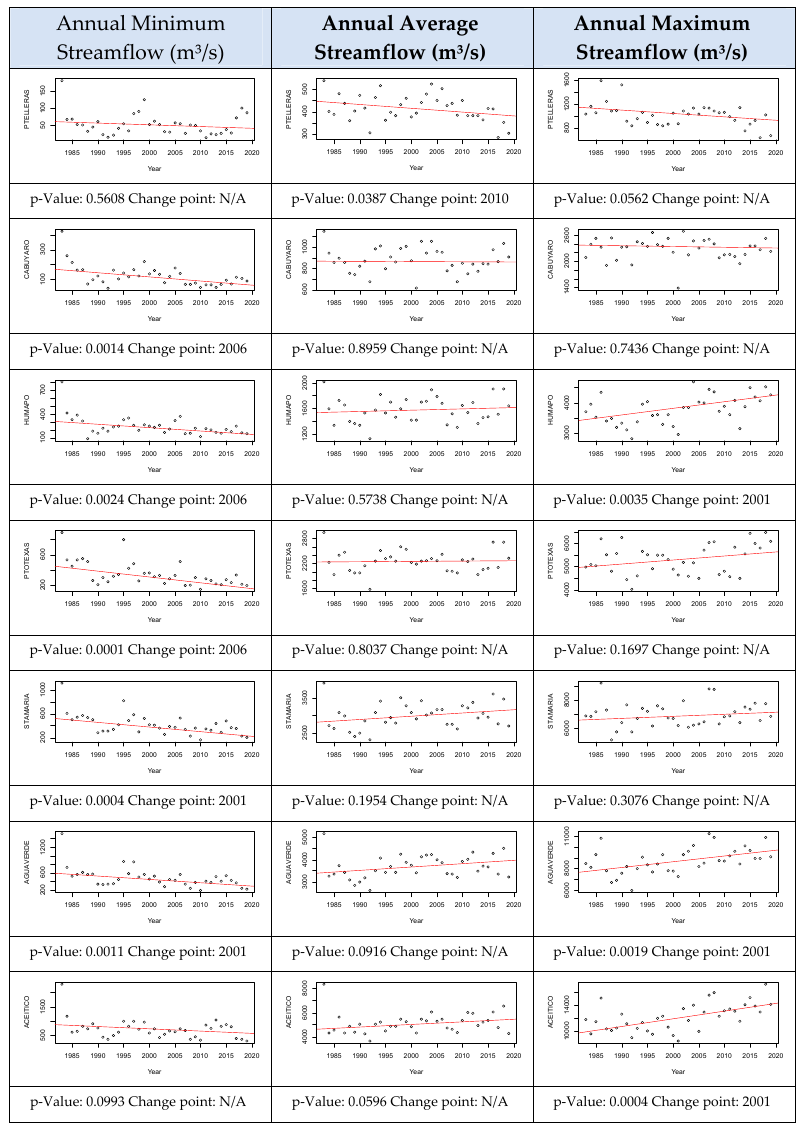
Figure 4. Schematic representation of trends in the Meta River annual streamflow for 1983–2019.